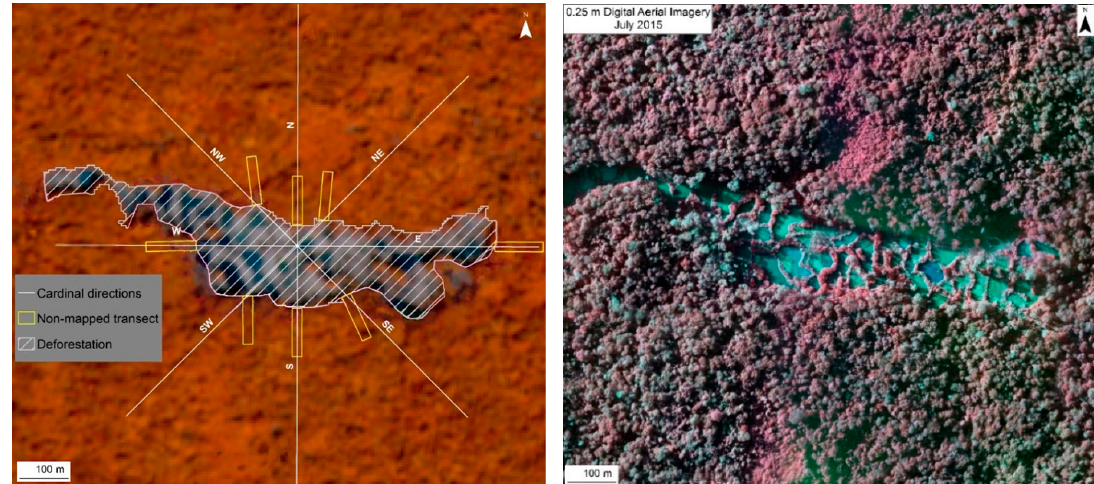
Figure 2. Example of a mined area, with pre-selected locations for degradation transects (left). The rectangles outlined in yellow show the potential locations of 20 by 100 m transects established within the fixed-area 100 m bu ff er, 5 m RapidEye (left) and 0.25 m digital aerial infra-red imagery (right) have been used by the Guyana Forestry Commission for mapping and validation, respectively.